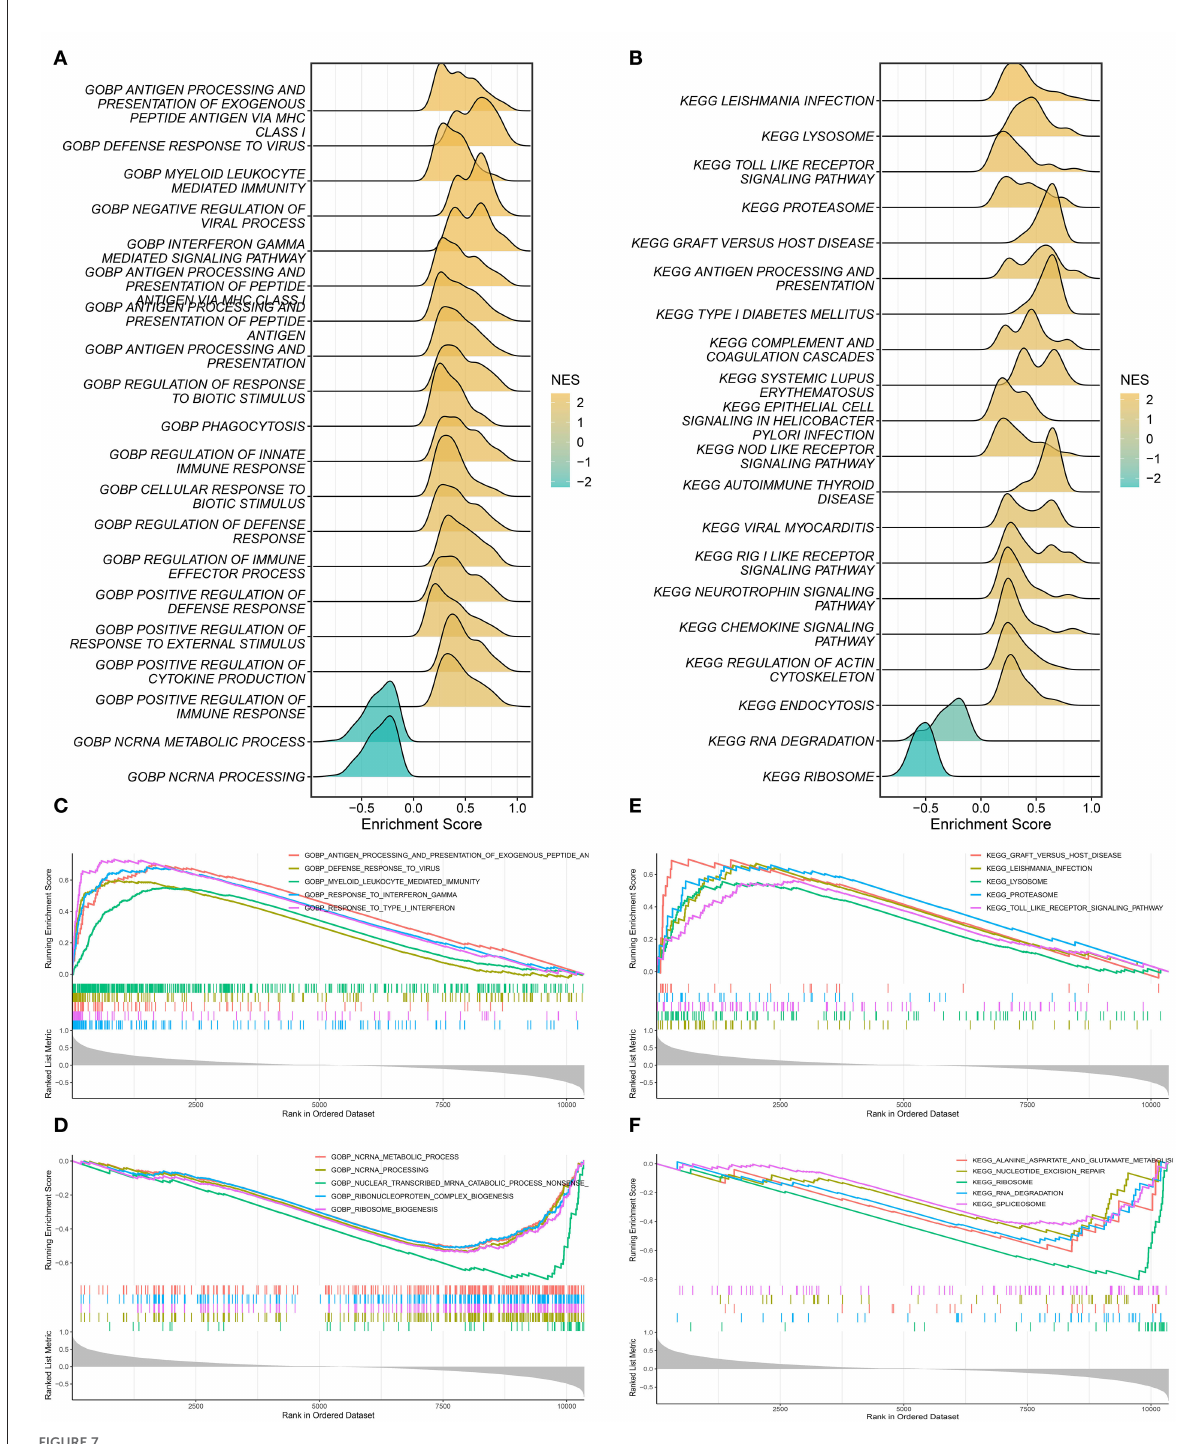
FIGURE7 Gene set enrichment analysis. (A) The ridge plot of the top 20 GO terms with ranked genes of the GSE83456. (B) The ridge plot of the top 20 KEGG pathways with ranked genes of the GSE83456. (C,D) The positive and negative top five GO terms with ranked genes of the GSE83456. (E,F) The positive and negative top five KEGG pathways with ranked genes of the